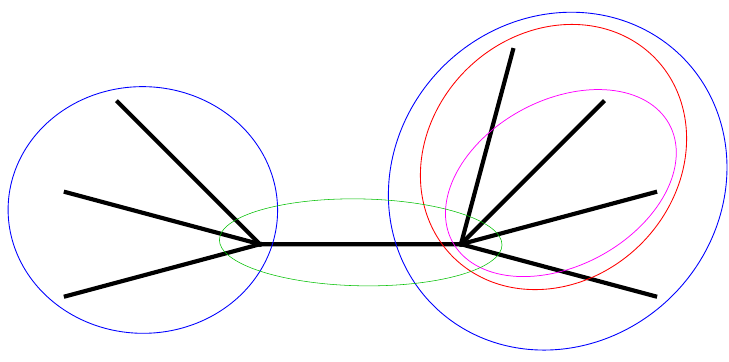
Figure 10. Examples of AI , AO , AS with given A in C n